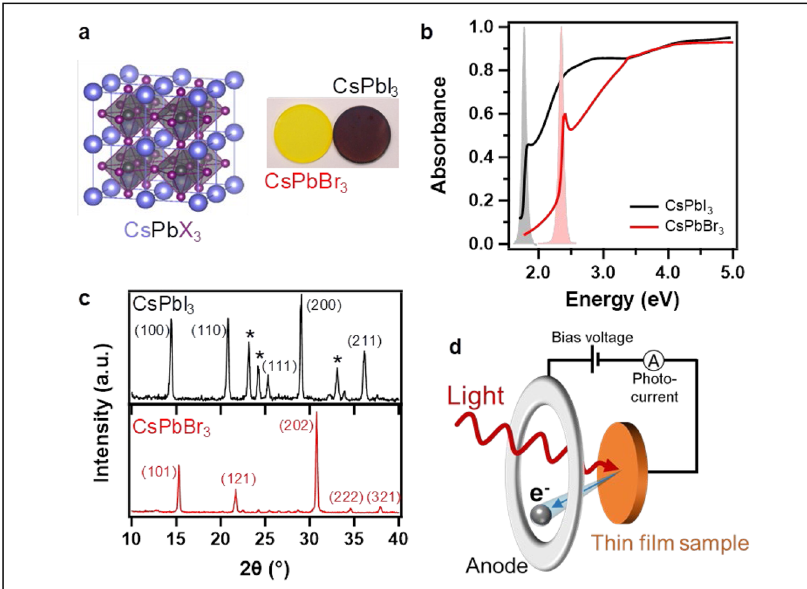
Fig. 1 Characterization of the halide perovskite thin fi lms. a Cubic structure of the halide perovskites and picture of thin fi lms on glass substrates. b Absorbance and photoluminescence (gray and red) spectra of the CsPbI3 and CsPbBr3 thin fi lms. c Corresponding X-ray diffraction spectra. The stars indicate the presence of a residual non-perovskite yellow phase in CsPbI3. a.u. denotes arbitrary units. d Schematic of the photoelectric effect measurement setup. The fi lms were prepared on 1 inch 2 silicon substrates for this